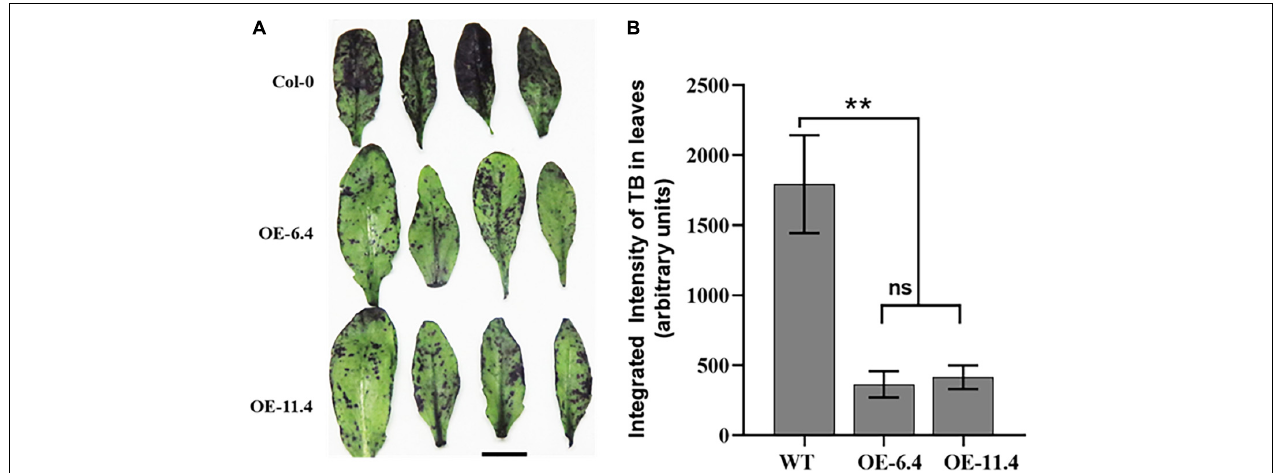
FIGURE 9 | Epidermal permeability assay in leaves of wt and RabA2b overexpressing plants. Rosette and cauline leaves were sampled from 4 weeks old wt or transgenic Arabidopsis plants. The leaves were incubated in aqueous solution of 0.05% (W/V) Toluidine Blue (TB) for 2 h and washed with water. (A) Leaves of wt, OE-6.4 and OE-11.4 after TB staining test, (B) quantification of the TB staining by imageJ analysis. Two asterisks (**) represents adjusted P -values between 0.01 and 0.001. Scale bar = 1 cm.